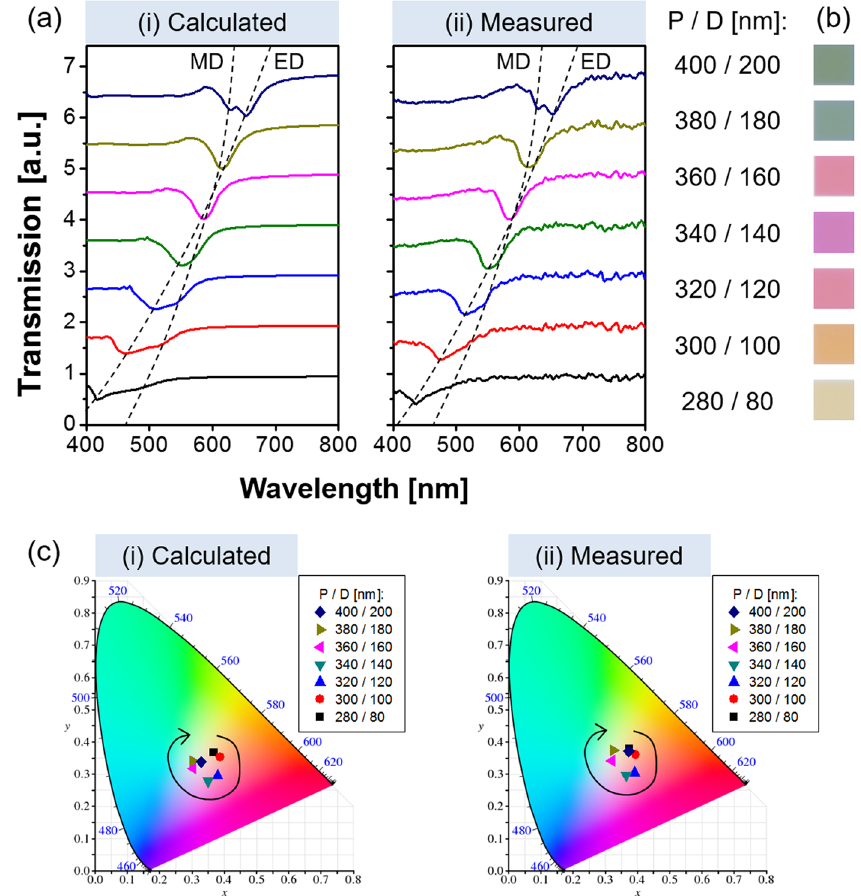
Figure 3. ( a ) (i) Calculated and (ii) measured transmission spectra when the period is varied from P = 280 nm to 400 nm under the relationship of P = D + 200 [nm], while the diameter is varied from D = 80 nm to 200 nm. The transmission dips for the ED and MD are traced by the dashed line. ( b ) Corresponding color images that are captured by an optical microscope. ( c ) Chromaticity coordinates corresponding to (i) the calculated and (ii) the measured spectra in the CIE 1931